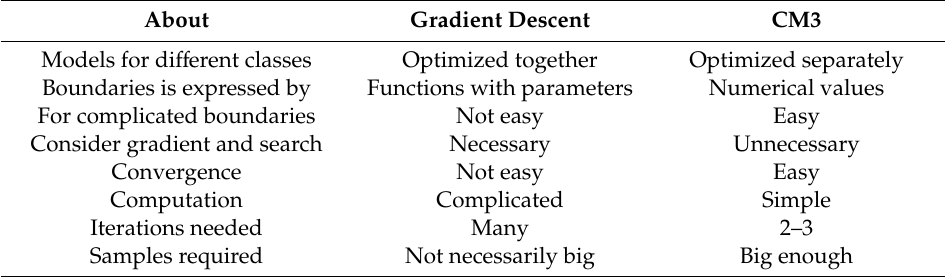
Table 6. Comparison of the CM algorithm and Gradient Descent for low-dimensional feature spaces. About Gradient Descent CM3 Models for di ff erent